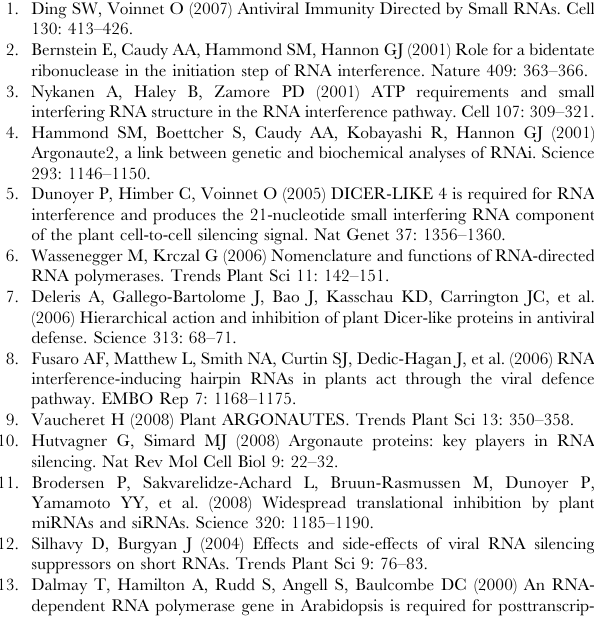
Table S1 Potential vsiRNA duplexes derived from the + strand. All sequences matching to the plus strand of the CymRSV genome were searched against the reverse complement of all plus strand genome matching sequences. Potential duplexes with four or fewer mismatches and a maximum of one bulge are listed. The number of reads is shown in brackets after each sequence. Table S2 Potential vsiRNA duplexes derived from the 2 strand. All sequences matching to the minus strand of the CymRSV genome were searched against the reverse complement of all minus strand genome matching sequences. Potential duplexes with four or fewer mismatches and a maximum of one bulge are listed. The number of reads is shown in brackets after each sequence. Table S3 Sequences of oligonucleotides. Sequences of oligonu- cleotides used for the dot blot and northern blots are